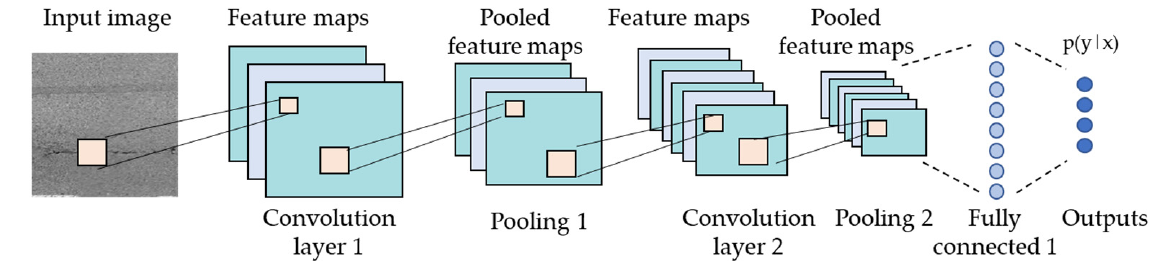
Figure 15. The result of merging the road section with its segmentation.